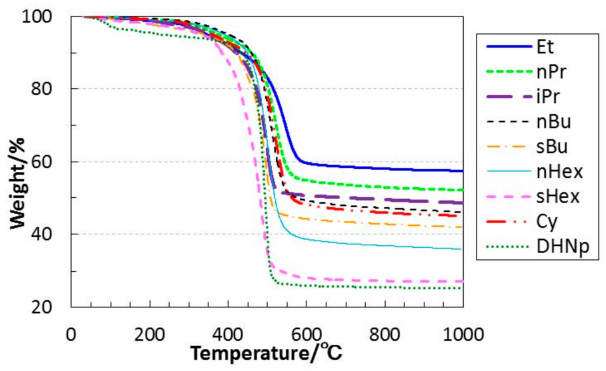
Figure 4. ( a ) 13 C– and ( b ) 29 Si–NMR spectra of as-synthesized ROSZs. (a1,b1) EtOSZ, (a2,b2) CyOSZ, and (a3,b3)